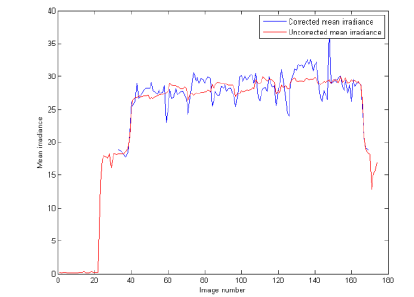
Figure 4. Average irradiance [ m W/cm 2 /nm] for a set of images.